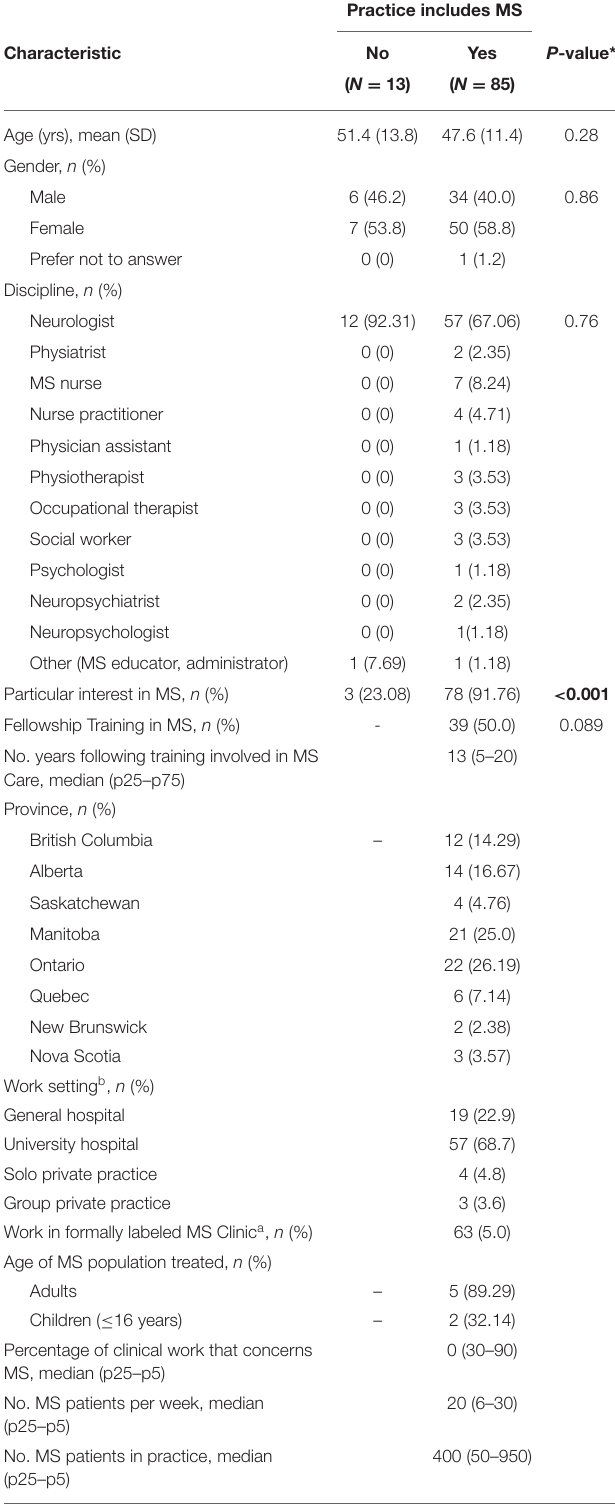
TABLE 1 | Characteristics of respondents, stratified according to whether practice includes people with multiple